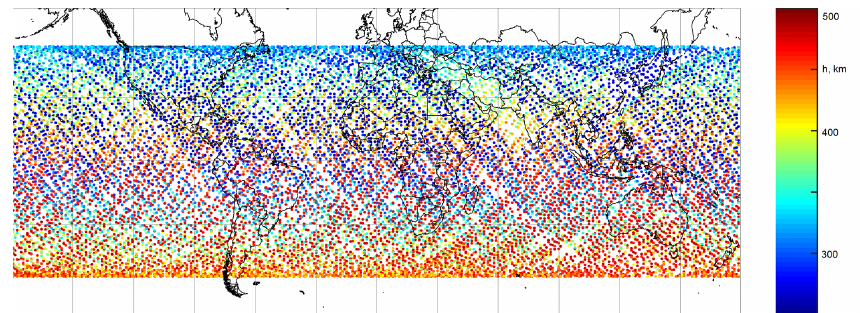
Figure 6. Kosmos-49 positions of measurements. Altitude is shown in color.